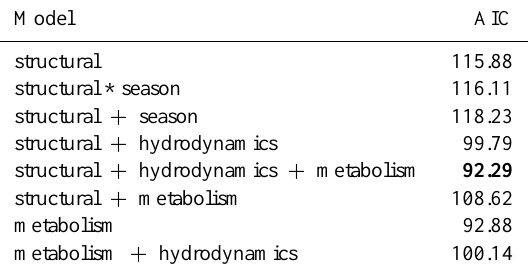
Table 7. Model selection for GLM models predicting CaCO 3 m − 2 with gaussian distribution and link identity. Structural and hydrody- namic components are summarized in the principal component from a PCA analysis (in R), explaining 73 and 99%, respectively of the original parameters. For Metabolism we used the range of oxygen concentration (mgL − 1 ) as a proxy. Aikaike’s information criterion (AIC) is as less-is-better, the best model value is highlighted in bold. Model AIC structural 115.88 structural * season 116.11 structural + season 118.23 structural + hydrodynamics structural + hydrodynamics + metabolism structural + metabolism metabolism metabolism +